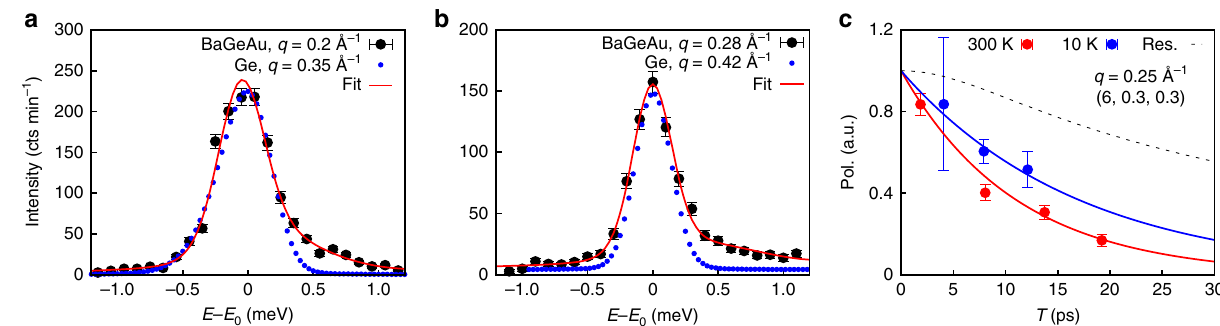
Fig. 4 Experimental measurements of transverse acoustic (TA) phonon lifetimes in Ba 7.81 Ge 40.67 Au 5.33 (BaGeAu). a , b Comparison between the TA 100 phonons in BaGeAu clathrate ( black points ) and in pure Ge ( blue dotted line ) measured with constant q -scans, at q = 0.2 Å − 1 and q = 0.28 Å − 1 where their local group velocities are identical. Measurements were performed on the triple axis spectrometer (TAS) 2T@LLB with an effective resolution of 200 μ eV. The Ge data represent directly the effective TAS resolution. Data are reported as a function of E – E 0 , with E 0 the acoustic phonon mode energy. In a , E 0 = 2.97 meV (BaGeAu) and E 0 = 5.72 meV (Ge); in b E 0 = 4 meV (BaGeAu) and E 0 = 6.75 meV (Ge). c Evolution of the neutron polarization as a function of τ 100 phonon ( q = 0.25 Å − 1 , E = 3.8 meV) measured with the Neutron Resonant Spin-Echo (NRSE) technic at 300 K ( full red circle ) and at 10 K NRSE for the TA 011 ( full blue circle ) measured on the spectrometer IN22-ZETA@ILL. Data are corrected for the experimental resolution shown as a dotted line . The full blue and red lines are exponential fi ts to the data from which phonon lifetimes equal to 33(10) ps and 15(1) ps at 10 and 300 K are extracted. Vertical error bars in a – c are s.d. arising from counting